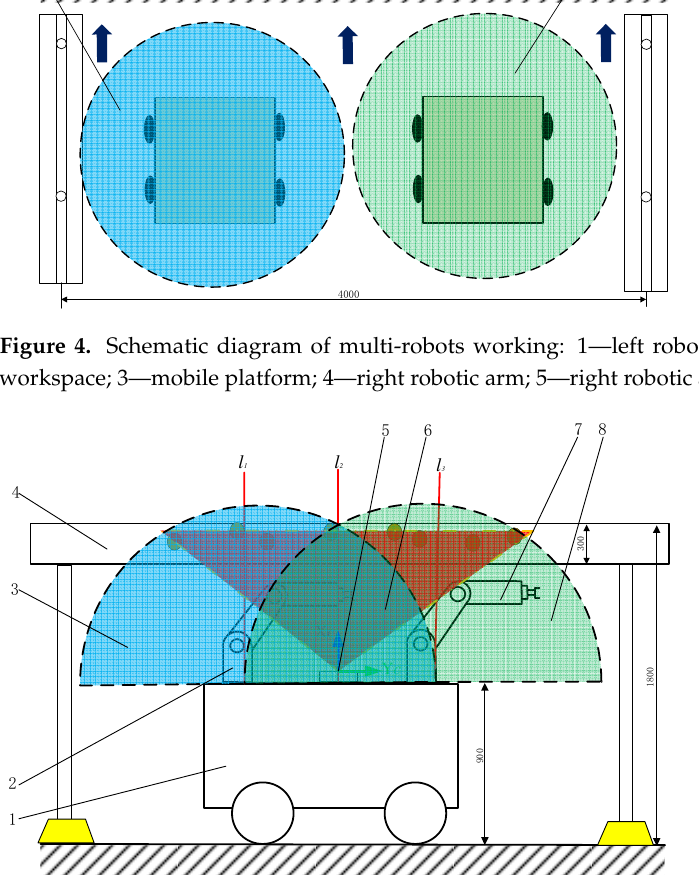
Figure 5. Schematic diagram of picking area division: 1—double-arm collaboration platform; 2—left robotic arm; 3—left robotic arm workspace; 4—shelf; 5—depth camera; 6—camera imaging space; 7—right robotic arm; 8—right robotic arm workspace.